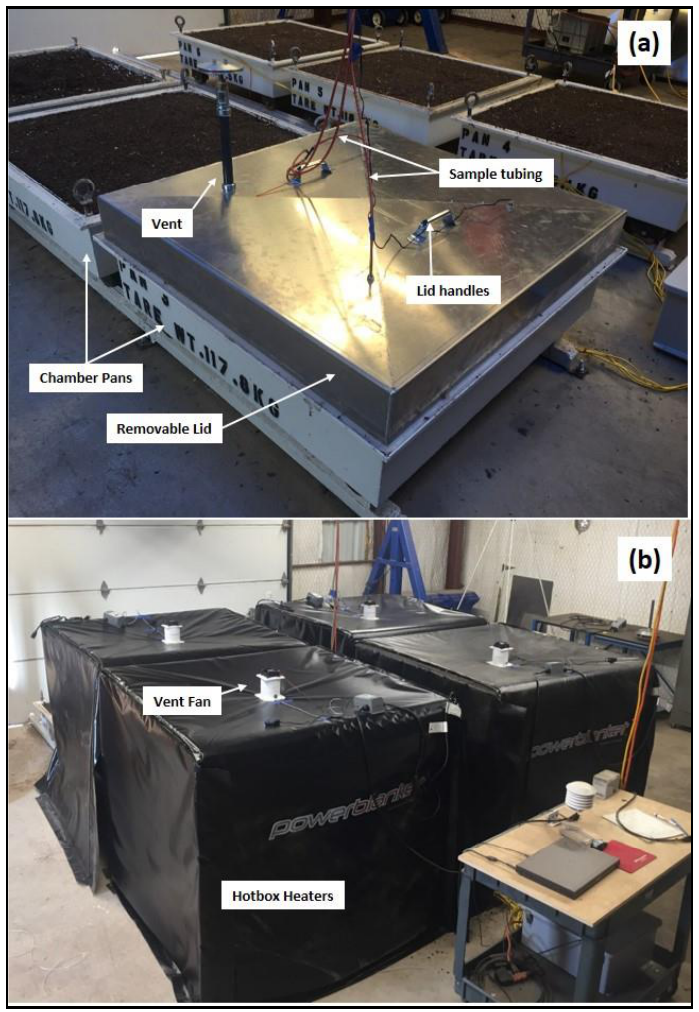
Figure 2. Equipment for determining nitrous oxide emissions from feedyard manure: ( a ) emissions were measured from five 1.0 m 2 (surface area) chambers sealed with a portable lid. Polyethylene tubing recirculated sampled air between chambers and a Los Gatos N 2 O analyzer; ( b ) chamber temperatures were controlled with vented thermal blankets. Source: Parker et al. [1].